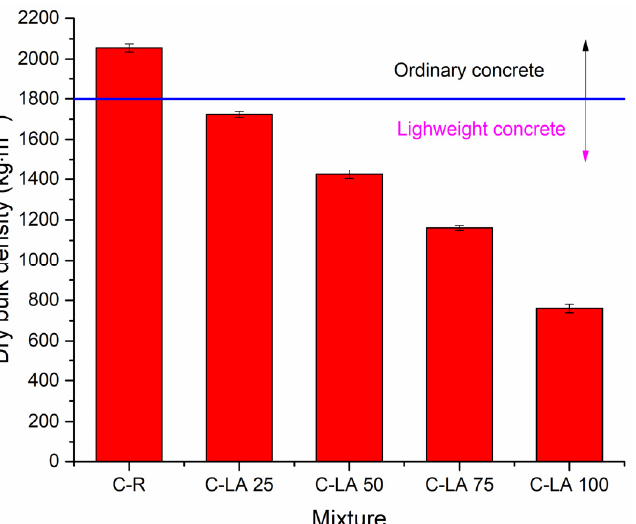
Figure 3. Dry bulk density of concretes in dependence on LA content. The value of 1800 kg · m − 3 is highlighted and the distribution into two different concrete classes according to EN 206-1 [52] is inserted.